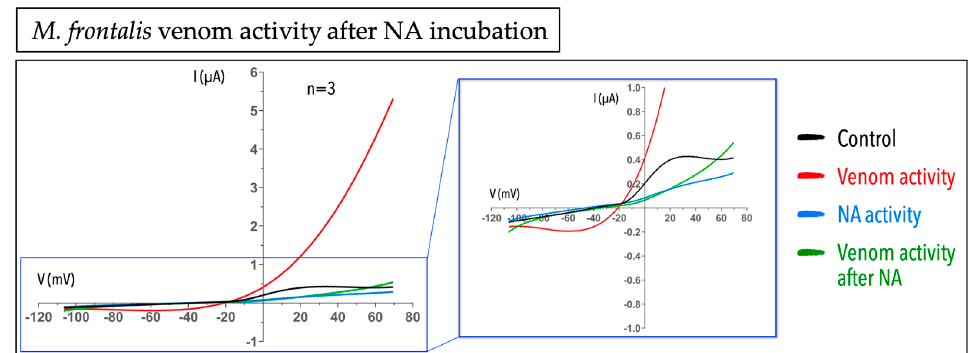
Figure 4. Micrurus frontalis venom causes a Cl − outward current by acting directly or indirectly on Ca 2+ -activated Cl − channels in X. laevis oocytes. The black line shows the control (the oocyte perfused with ND96); the red line shows the activity of 50 µg of M. frontalis venom on oocytes; the blue line shows the oocyte current in the presence of 100 µM of NA; and the green line shows the activity of 50 µg of M. frontalis venom after cell incubation with 100 µM of NA, where the outward current evoked by the venom is no longer observed. The blue box on the right of the panel shows a zoom of the graph. The graphs show the trace of one experiment from a series of independent experiments.